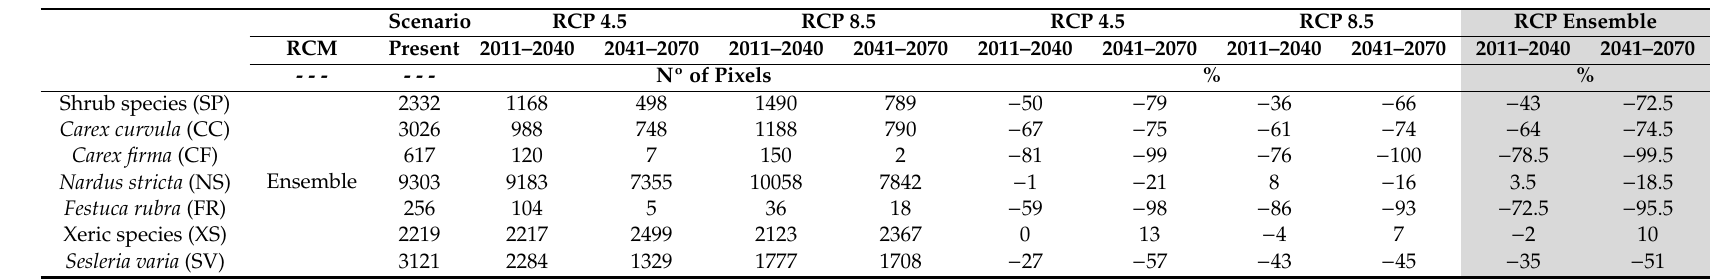
Table 4. Changes of pasture macro-type suitability under future climate scenarios (RC 4.5 and 8.5) and time slices (2011–2040, 2041–2070) with respect to current climate conditions, as reported by the table, 100 ha wide each on the left side of the table; percentage of variation with respect to the present on the center of the table (light grey background), averages of percentage of variation for both RCP 4.5 and 8.5 scenarios (dark grey) on the right side of the table (RCP